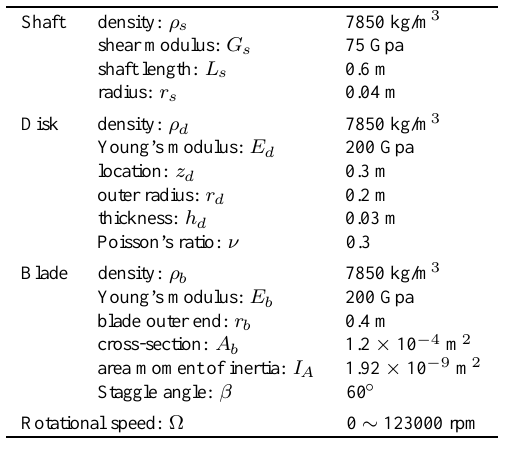
Table 1 Geometric and material properties of the illustrated examples